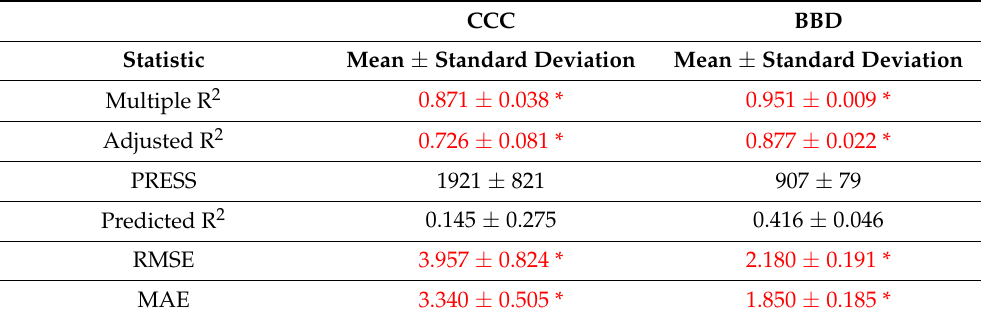
Table 2. Summary statistics for the optimization of photoporation yield using PDNPs as photothermal NPs and FD500 as cargo molecules, with both a CCC design and BBD. Triplicates were performed to assess model output reproducibility. The mean and standard deviation of the triplicates are presented. Values indicated in red and with * are significant at p < 0.05 for a one-sided unpaired Welch’s t -test between the CCC design- and BBD-based model summary